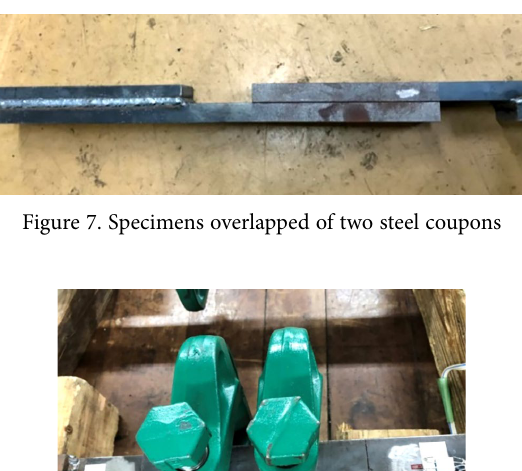
Figure 4. Name of the specimens for tensile test